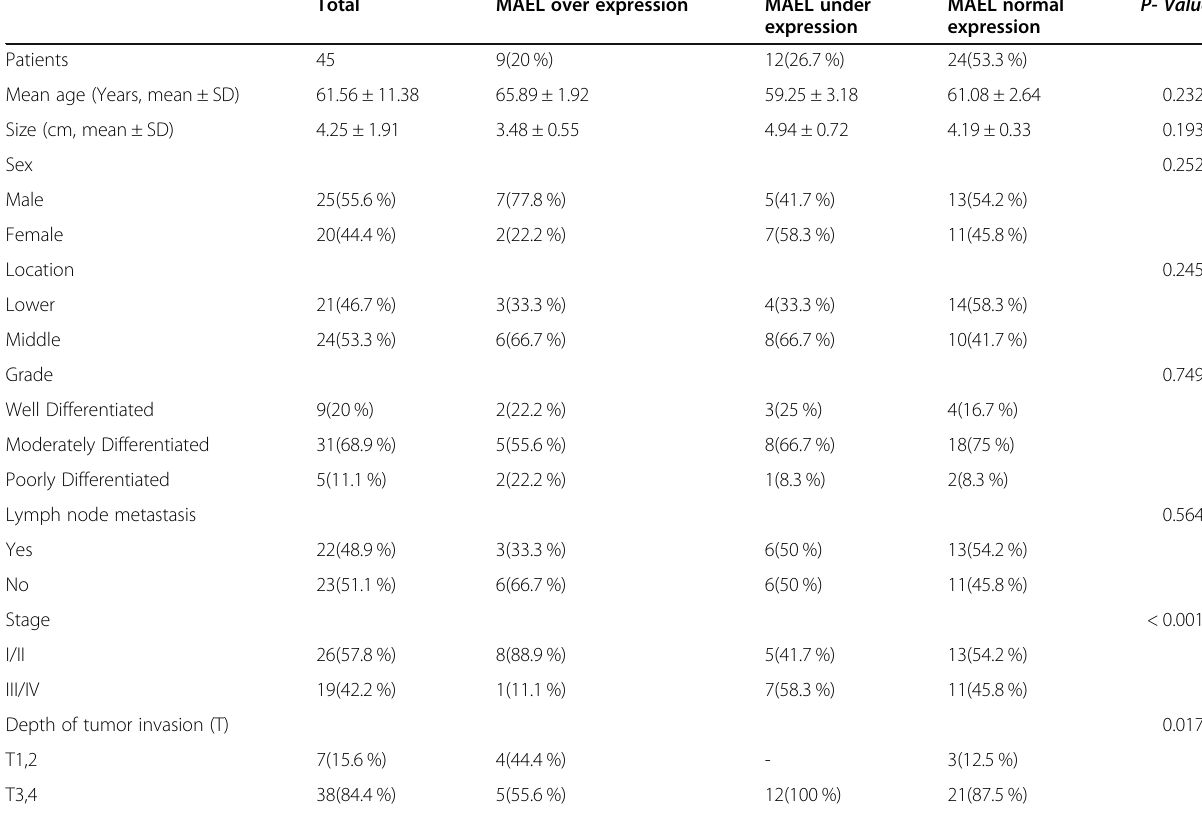
Table 1 Correlation between level of MAEL mRNA expression and clinicopathological features of ESCC